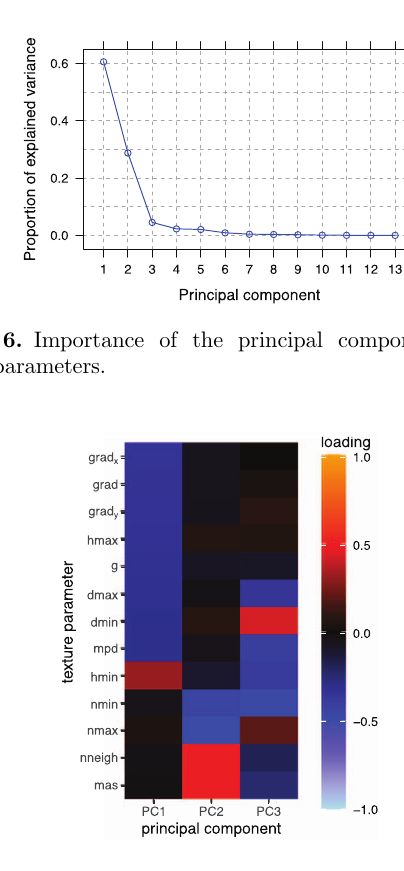
Figure 7. Loading vectors of the fi rst three principal compo- nents of the PCA, the loading strength is